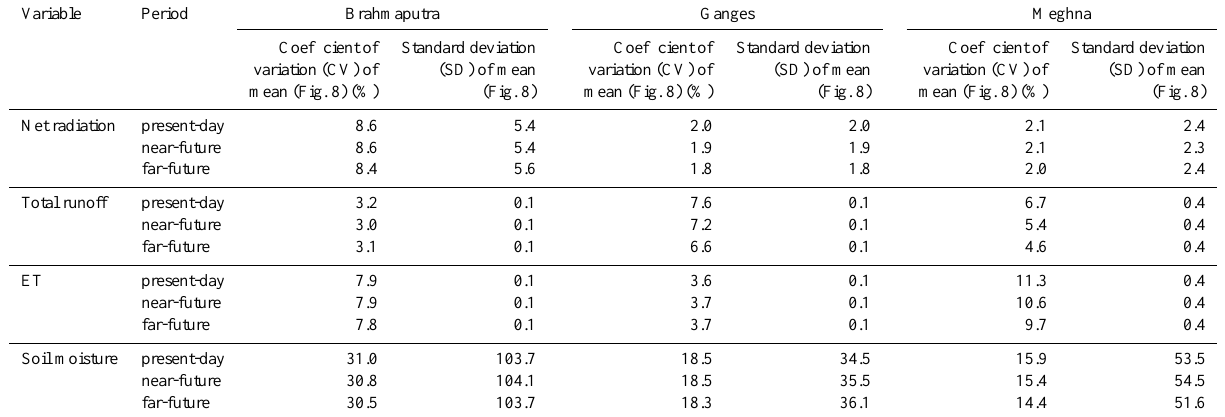
Table 7. Statistical indices (the CV and SD) of the uncertainty in model simulations due to the uncertainty in model parameters. Variable Period